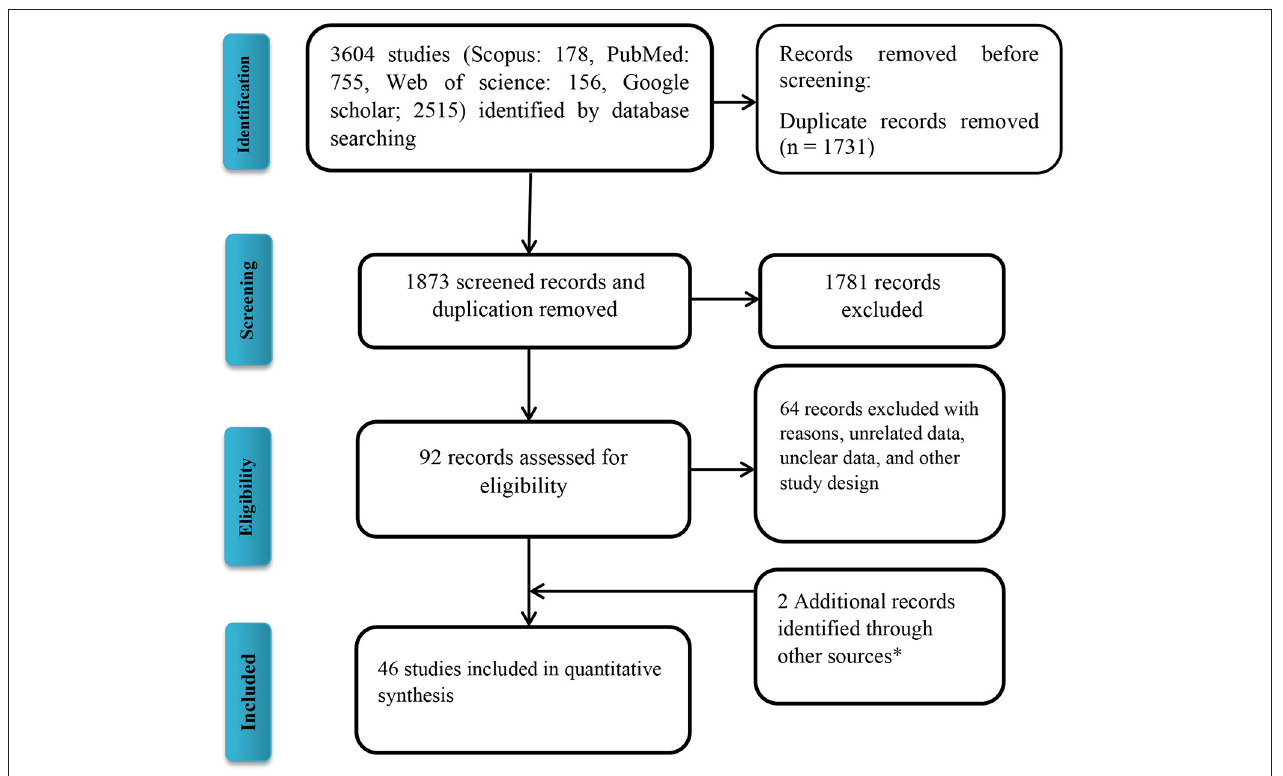
FIGURE 1 | Flow diagram of the literature search for studies included in the meta-analysis. *Including manual search and library